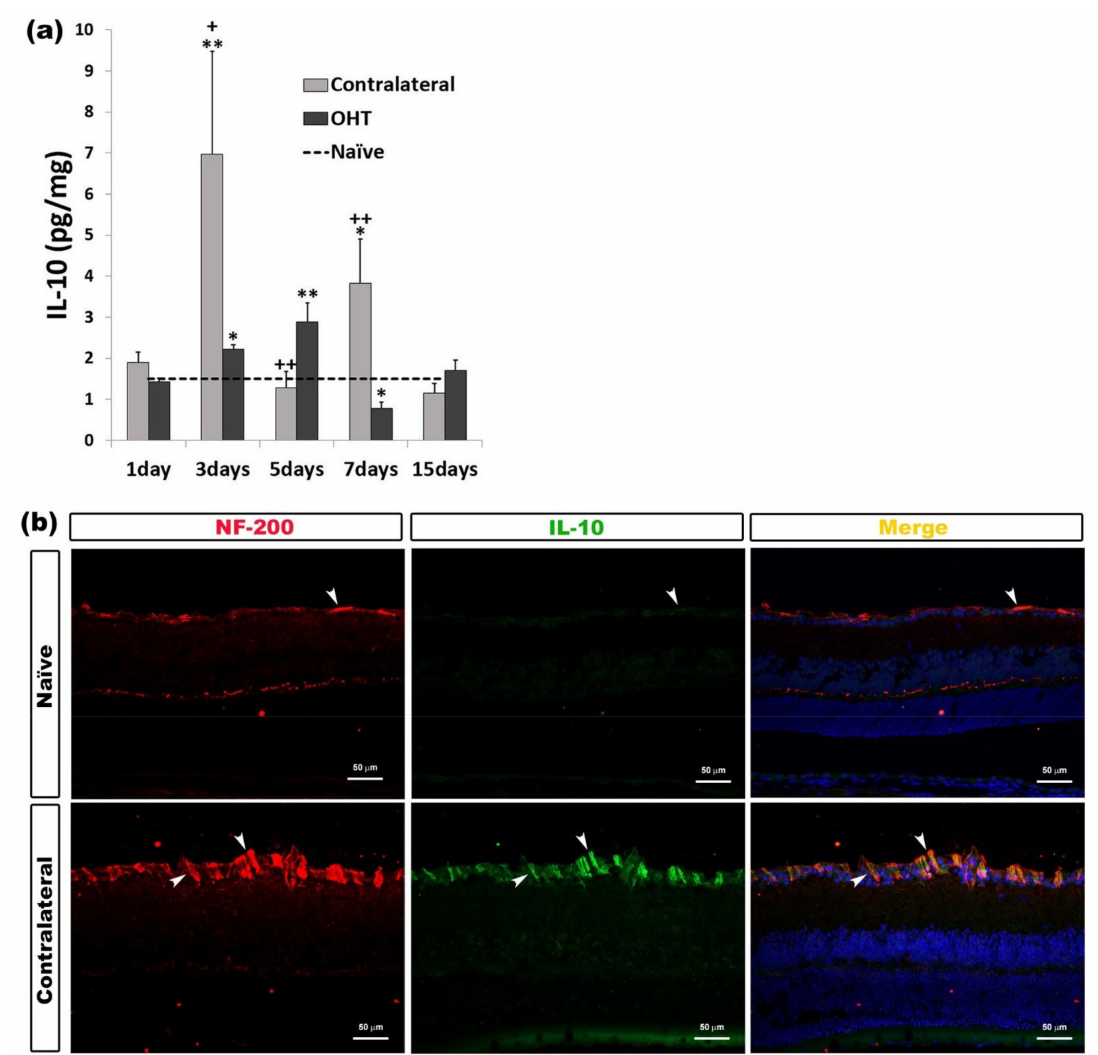
Figure 8. IL-10 levels at different times after laser-induced ocular hypertension (OHT). ( a ) The variation over time in the IL-10 levels in the multiplex assay. The histogram shows the mean levels ( ± SD) of IL-10 (pg/mg) at days 1, 3, 5, 7, and 15 after laser OHT induction, in ocular hypertension eyes (OHT) and in contralateral eyes. The dashed line indicates the mean levels in naïve eyes. Statistical significance indicators: * p < 0.05, ** p < 0.01 vs. naïve; + p < 0.05, ++ p < 0.01 vs. OHT. ( b ) Immunohistochemical study of IL-10 expression in contralateral eyes three days after unilateral laser-induced OHT. Retinal sections were immunolabeled with antibodies to IL-10 (green) and NF-200 (red). Merge (yellow). The arrowheads indicate the co-expression of NF-200 (retinal ganglion cell (RGC) axons) and IL-10 in naïve and contralateral eyes; it is more intense in contralateral eyes. Abbreviations: OHT (ocular hypertension); IL-10 (interleukin 10); NF-200 (neurofilament of 200